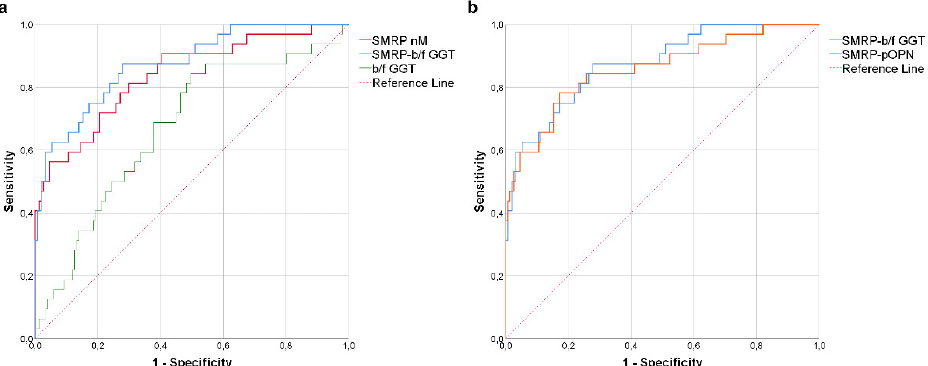
Figure 2. ( a ) ROC curve describing the diagnostic power of mesothelioma patients (MPM) vs. previously exposed workers (pe-W), by soluble mesothelin-related peptide (SMRP), big/free-GGT activity ratio (b/f GGT), and the combination of the two biomarkers (SMRP-b/f GGT); ( b ) comparison between the ROC curve of SMRPb/f GGT and combination of SMRP and plasmatic osteopontin (SMRP-pOPN).